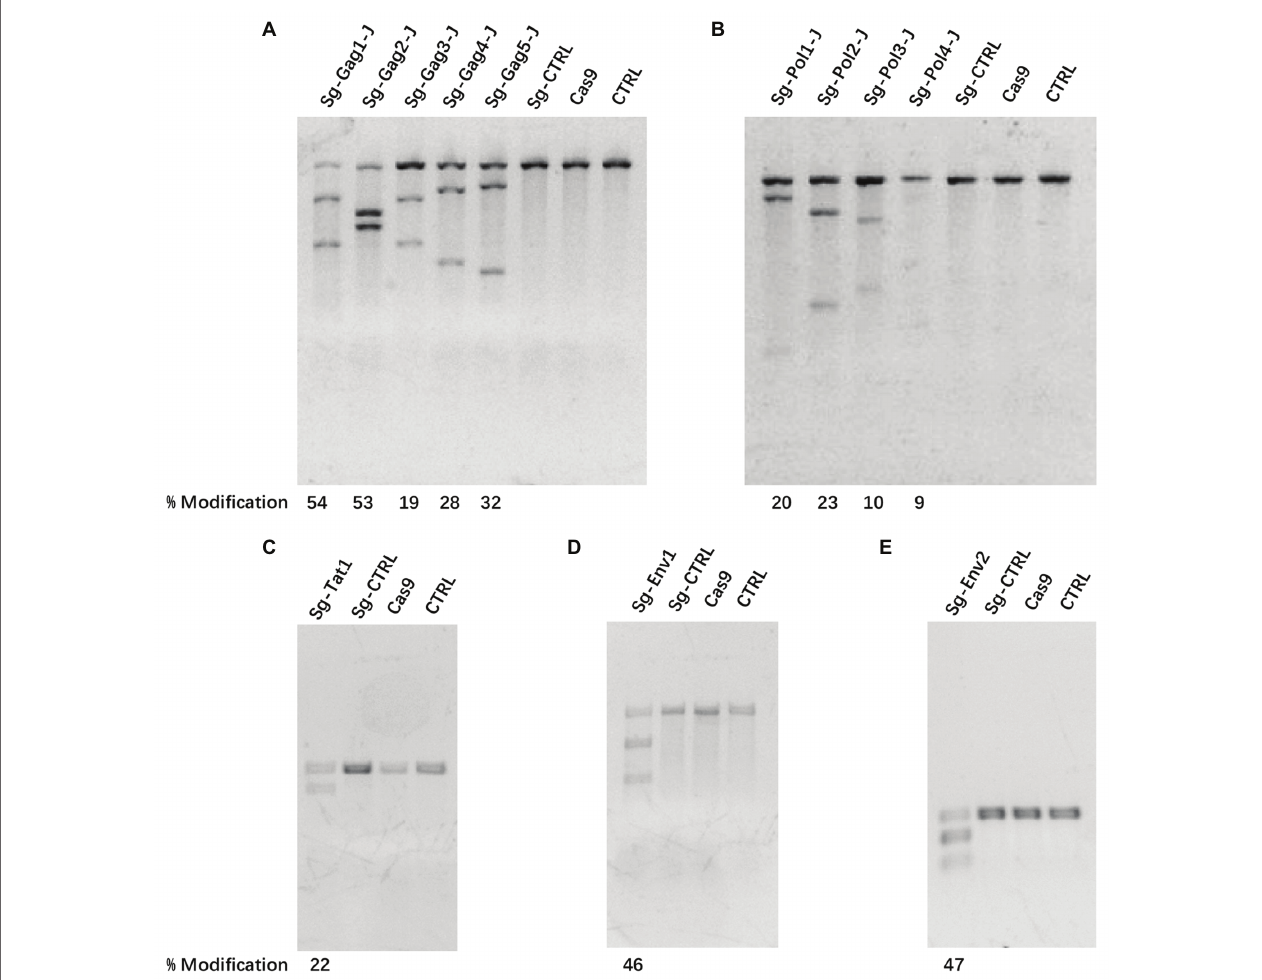
FIGURE 2 | The efficiency of clustered regularly interspaced short palindromic repeats (CRISPR)/Cas9 treatment-induced cleavage of HIV-1 DNA. (A–E) Mutational outcomes of 12 sgRNA/Cas9 treatments were determined using a T7 endonuclease I (T7EI) assay. Cas9, cells only expressing the Cas9 protein; CTRL, cells before transfection.